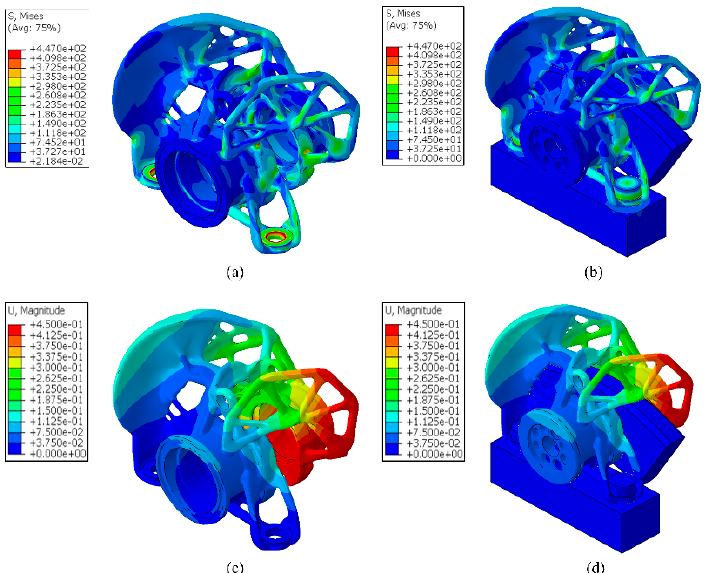
Figure 12. The results of the validation studies in ABAQUS for the rear caliper: ( a ) Stress plot of the rear housing, ( b ) Stress plot of the rear caliper, ( c ) Total displacement of the rear housing, and ( d ) Total displacement of the rear caliper.